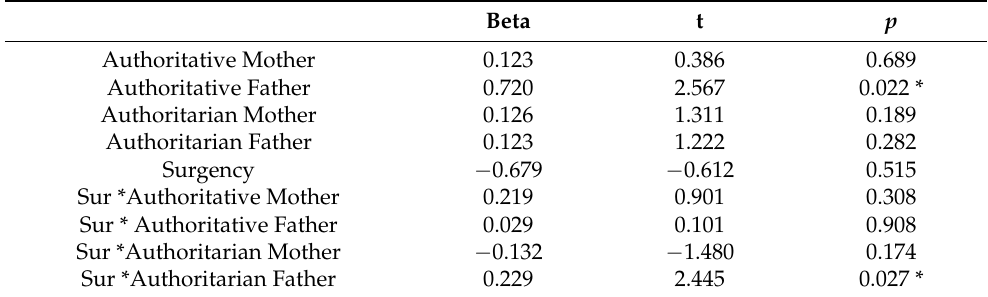
Table 3. Regression analysis for boys’ reactive aggression including parenting styles and surgency.